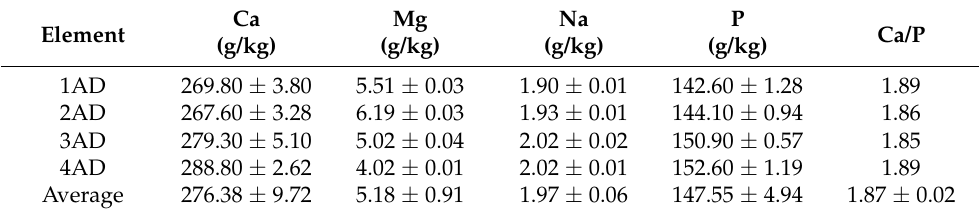
Table 2. Concentration of the macro-elements ( ± standard deviation) in teeth samples.